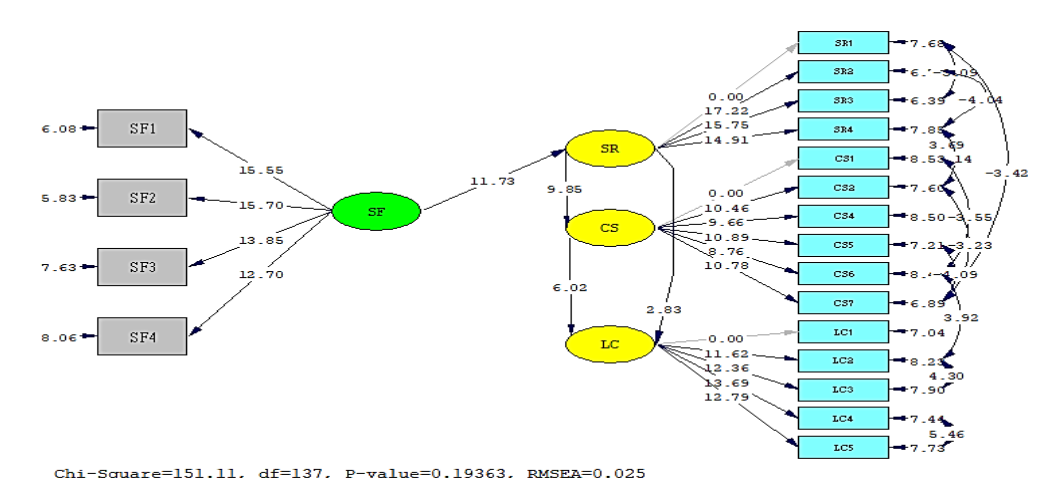
Figure 2. Path Diagram of